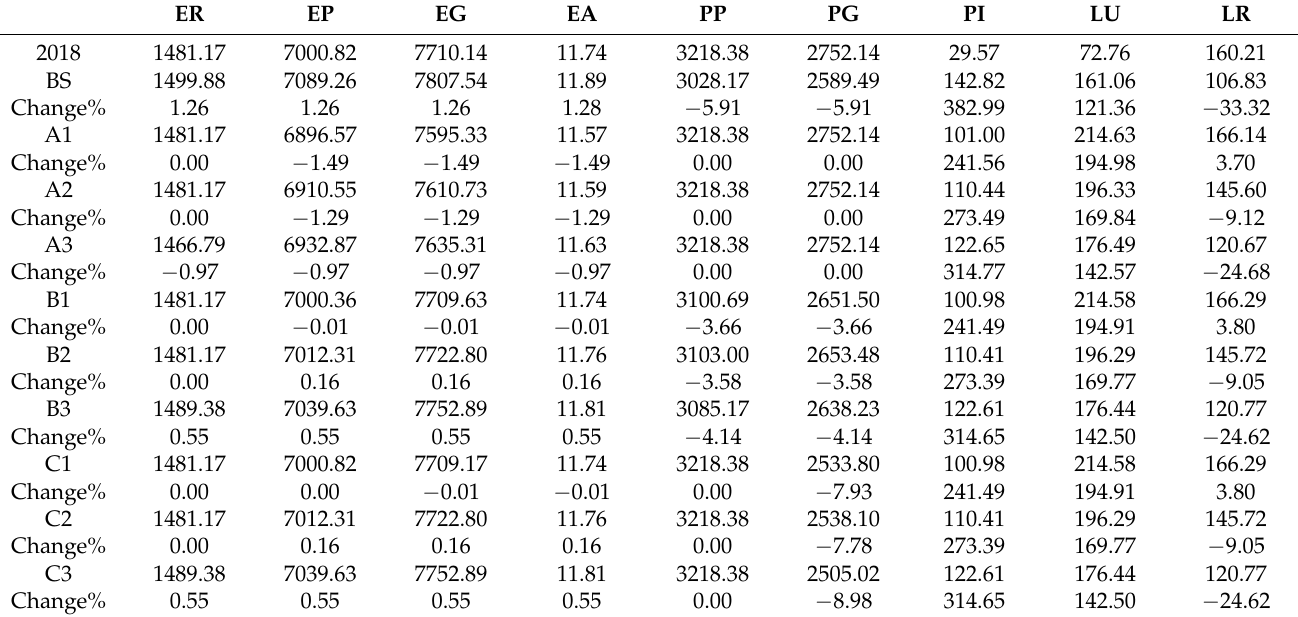
Table 8. Land area of the PLE spaces in 2030 and changes compared with 2018 under different